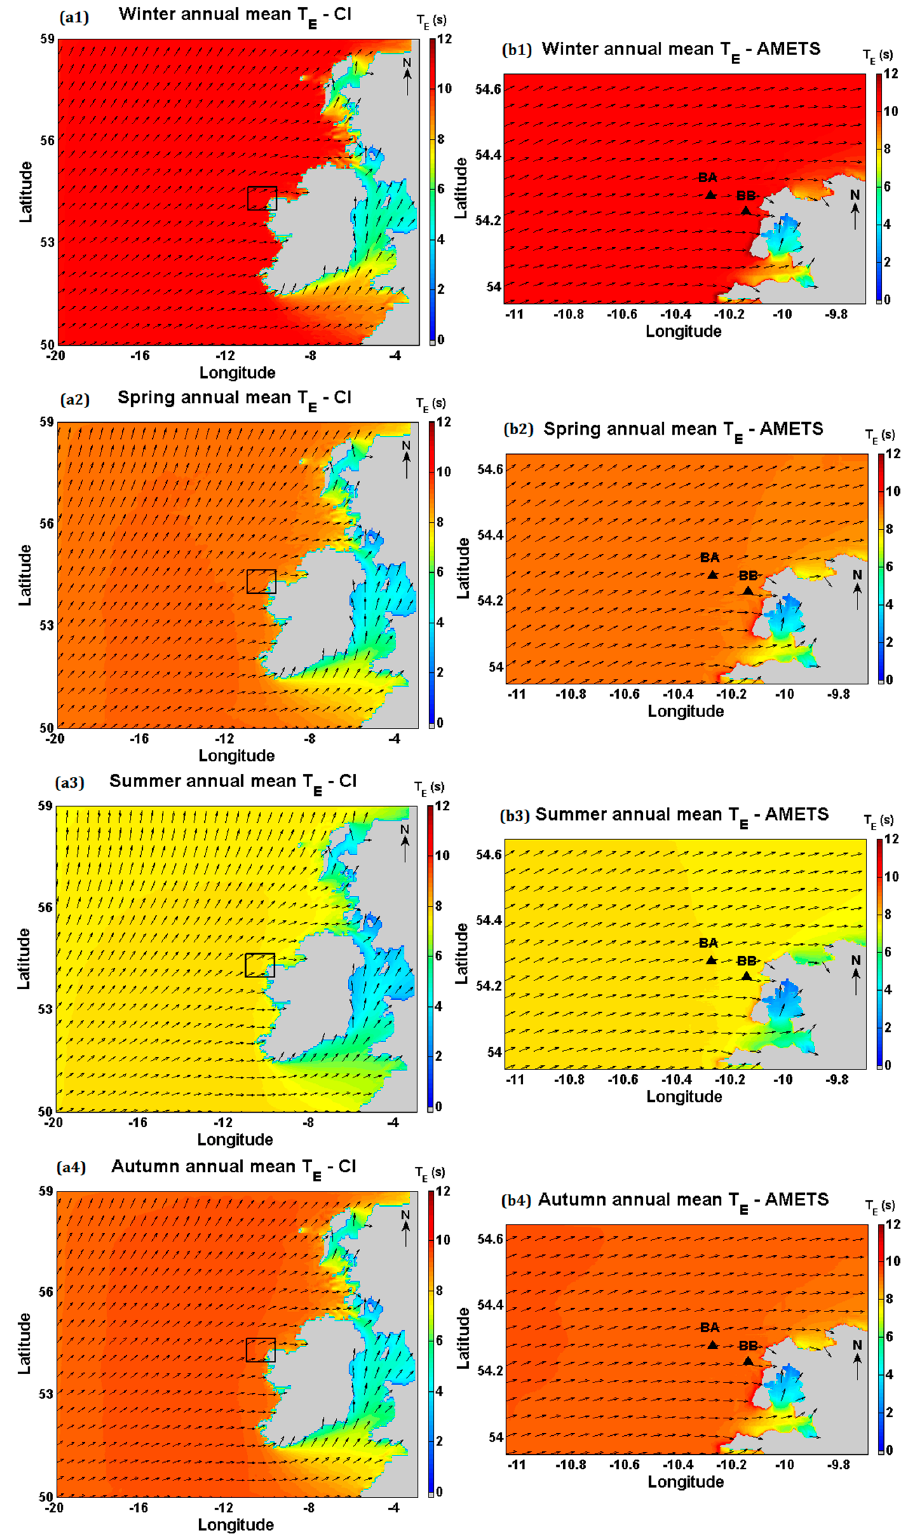
Figure 12. 12-year seasonal mean of T E (s) and MWD for ( a1 – a4 ) CI model and ( b1 – b4 ) AMETS model.